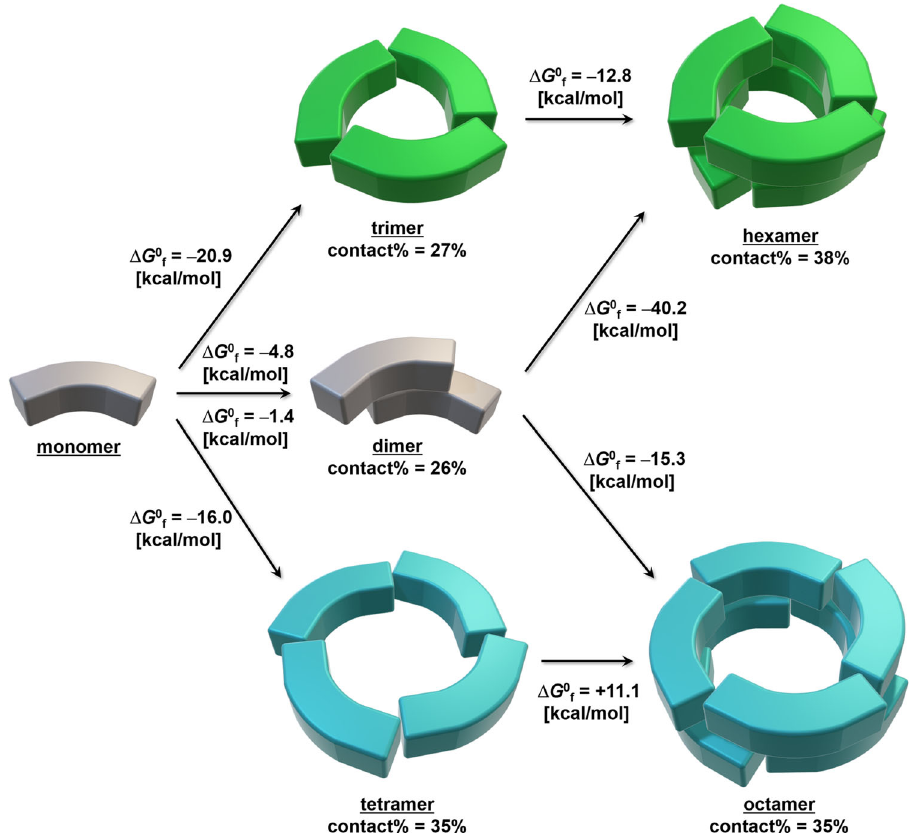
Fig. 4 Proposed oligomerization mechanism in Tl CPC. Monomeric ( αβ ) structures are represented by bended cuboids. Contact% was calculated by the PISA program based on the monomeric ( αβ ) units. Δ G 0 f values were calculated from Δ G 0 diss values, where the Δ G 0 f values of – 4.8 and – 1.4 kcal/mol in the dimer were calculated using the crystal models of Tl CPC-6 and Tl CPC-8,